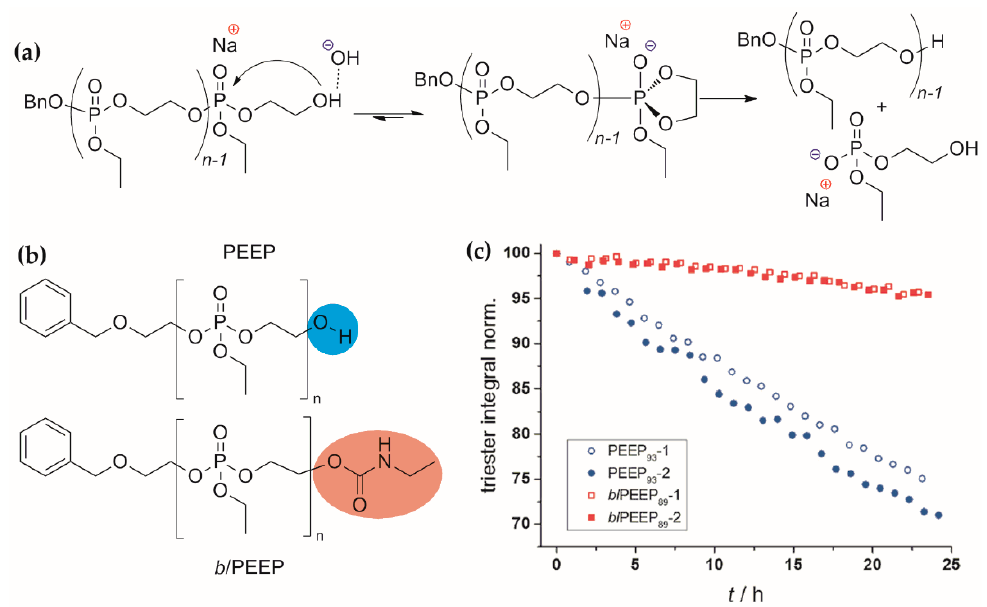
Figure 1. ( a ) Backbiting mechanism of hydrolytic degradation of poly(alkyl ethylene phosphate)s; ( b ) Structures of polymers with CH 2 CH 2 OH and urethane-blocked CH 2 CH 2 OH end-groups; ( c ) Degradation profile of PEEP and bl PEEP derived from 31 P NMR spectra (two runs for each polymer are shown). Reprinted with permission from [78]. Copyright (2018) Elsevier B. V.